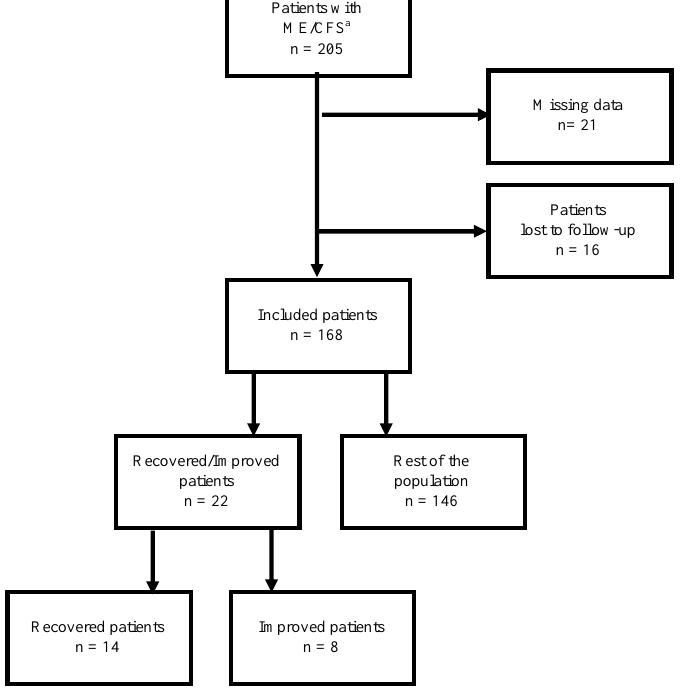
Figure 1. Flow chart of patients’ inclusion. a Myalgic encephalomyelitis/chronic fatigue syndrome.